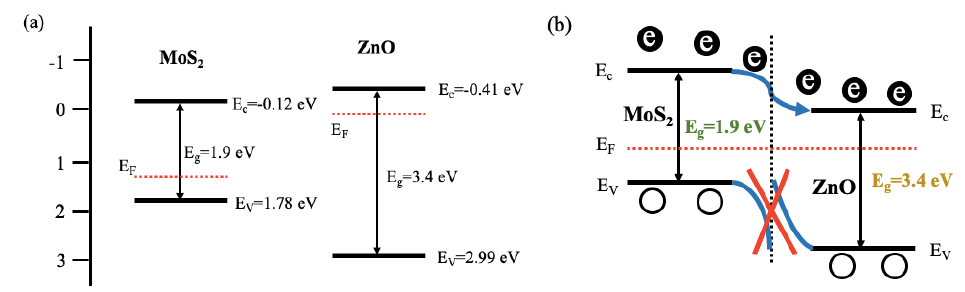
Figure 14. ( a ) Schematic diagram of the energy band positions between MoS 2 and ZnO before and ( b ) after contacting.